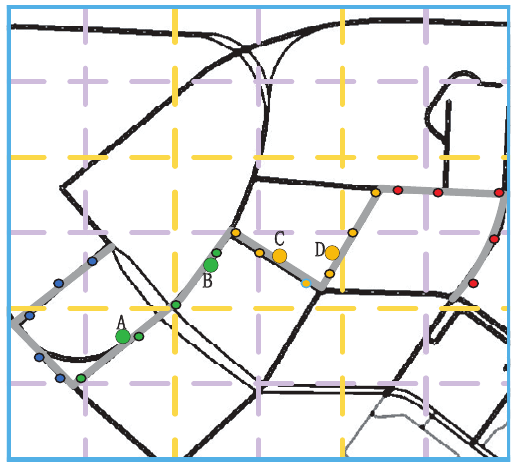
Figure 11. Illustration of Spatial Generalization. The entire area is divided into 6 × 6 blocks bounded by yellow and gray dotted lines. After the spatial generalization, A and B are in different blocks, while C and D are in same block. So A and B are distinguishable, C and D are undistinguishable. We say that the 6 × 6 spatial resolution cannot tell C from D . When spatial resolution level is reduced to 3 × 3 (divided by yellow dotted line), B is mingled with C and D